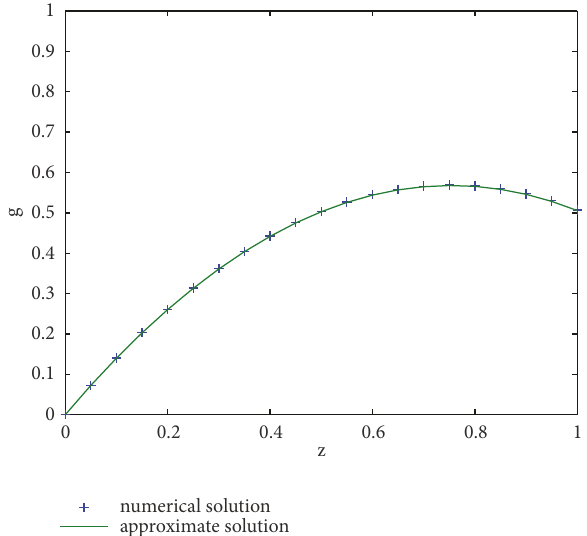
Figure6:Thecomparisonoftheresultsofapproximatesolutionand numerical solution for 𝛼 = 0.1 , 𝑛 = 2.5 , 𝑘(𝑧) = 𝑧 , ℎ(𝑧) = 1 − 𝑧 .